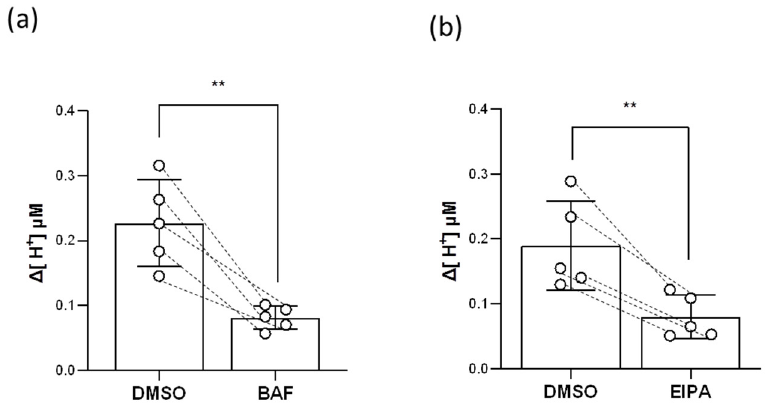
Figure 6. Effects of BAF and EIPA on the branchial H + -excreting capacity. H + gradients at the gills were analyzed before and after BAF ( a ) or EIPA ( b ) treatments by the SIET. The dashed line represents the same fish. Values are the mean ± SD (N = 5). Student’s t -test, ** p < 0.01. BAF = bafilomycin A1. EIPA = 5-ethylisopropyl amiloride.